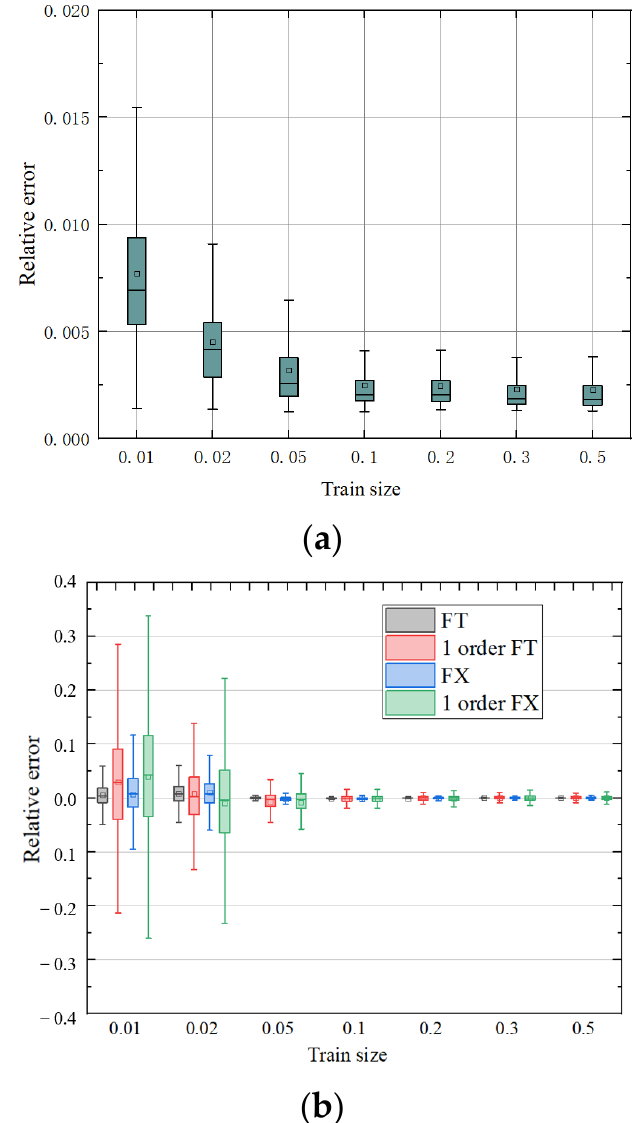
Figure 6. The trend of model prediction error. ( a ) Mean prediction error of flow field. ( b ) Relative error of airflow force prediction.